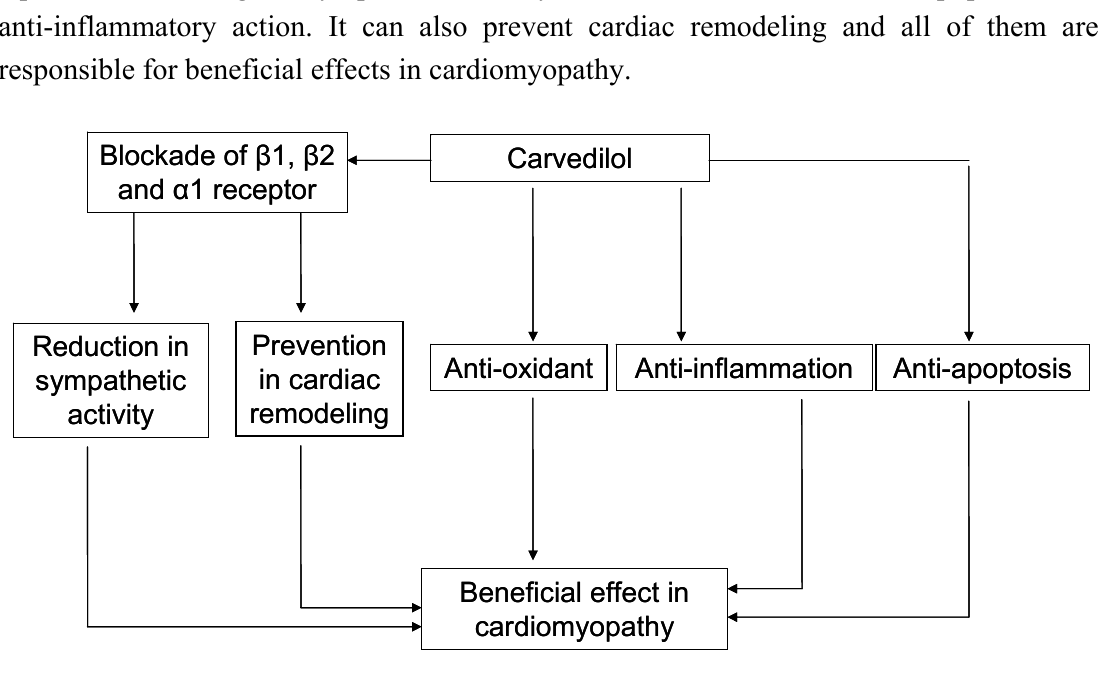
Figure 1. Pathways through which carvedilol exert beneficial effects in